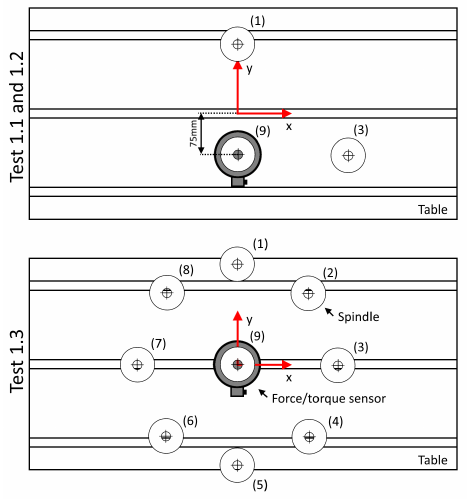
Figure 5: 3-axis CNC: machine position at different measuring points relative to the centre of